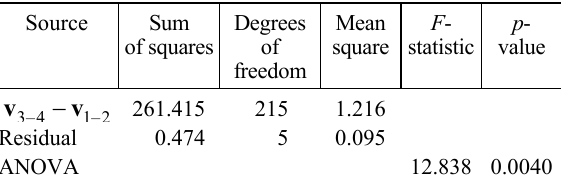
differences of the vertical velocities